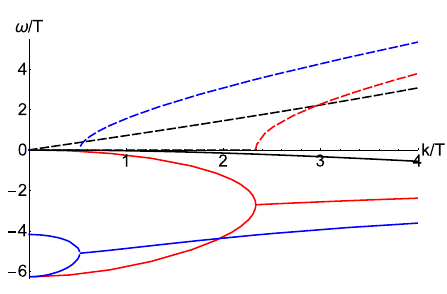
Figure 5 . The electromagnetic QNM of (cid:12)gure 4 but here with ! in the complex plane, plotted for several di(cid:11)erent values of k . Arrows indi- cate increasing values of k . Note how the two poles moving along the imaginary axis collide and give rise to two symmetric poles about the imaginary